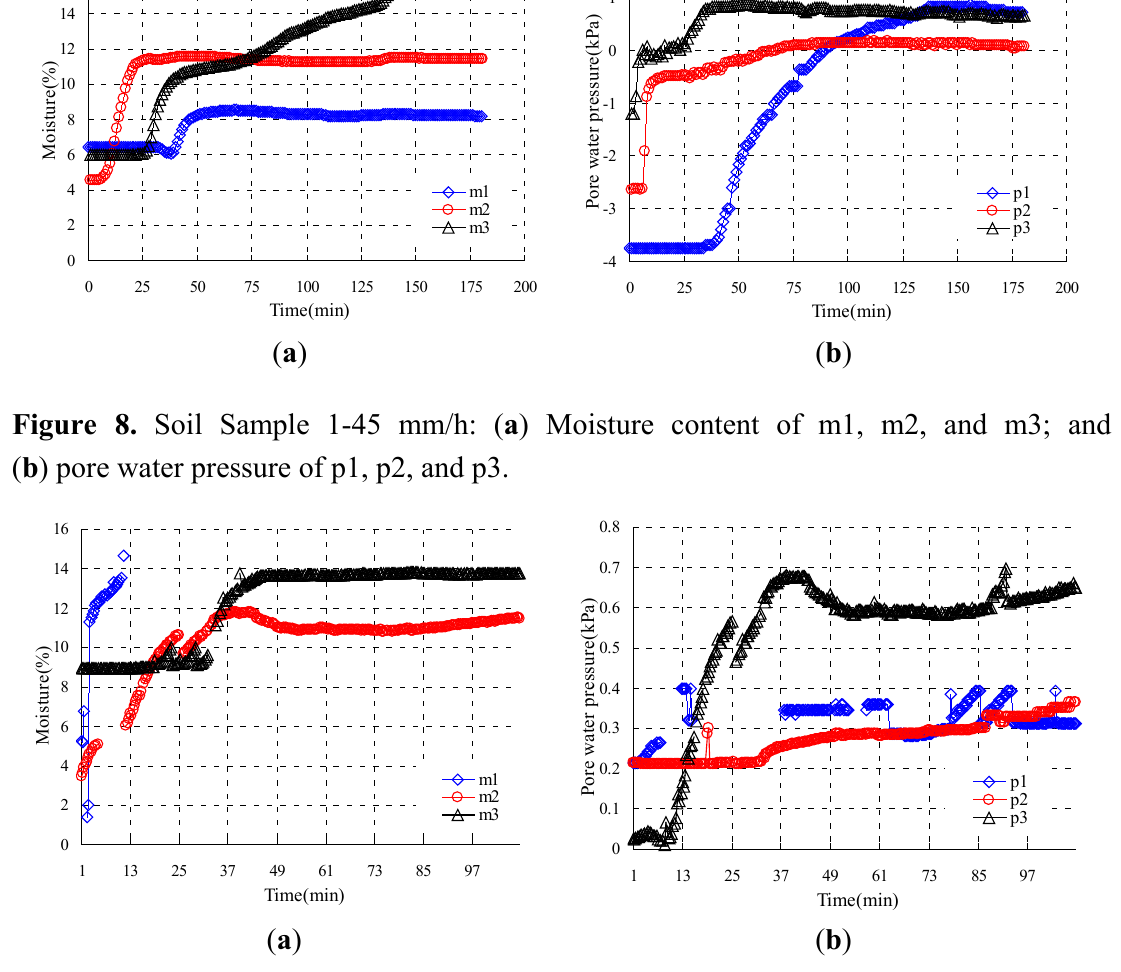
Figure 9. Soil Sample 1-65 mm/h: ( a ) Moisture content of m1, m2, and m3; and ( b ) pore water pressure of p1, p2, and